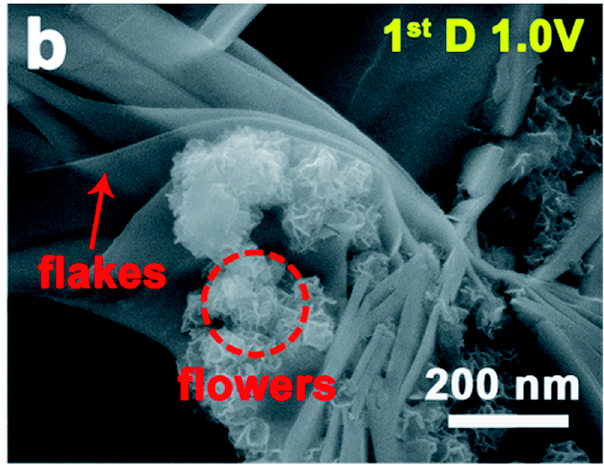
Figure 8. SEM image of Mn 3 O 4 nanoflowers after discharge, showing the large flakes of ZnSO 4 ⋅ 3Zn(OH) 2 ⋅ 5H 2 O. (From reference [103] with